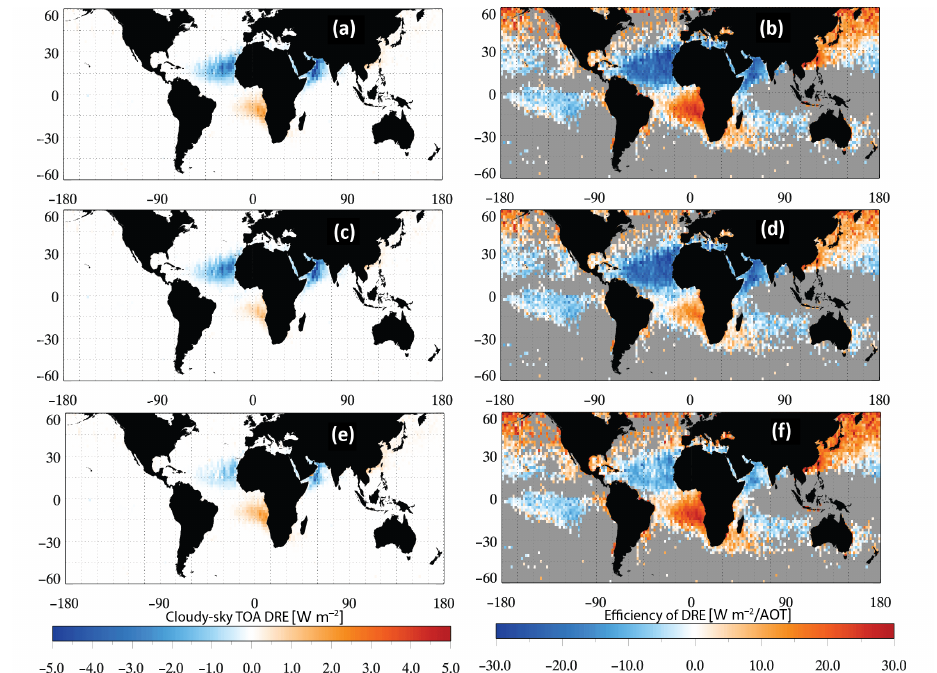
Figure 14. Annual mean cloudy-sky (a) DRE at TOA and (b) DRE efficiency due to ACA computed using the control run aerosol models; (c) and (d) are the same as (a) and (b) , except that the CALIOP smoke model has been replaced by the Haywood smoke model; (e) and (f) are the same as (a) and (b) , except that the OBS dust model has been replaced by the OPAC dust